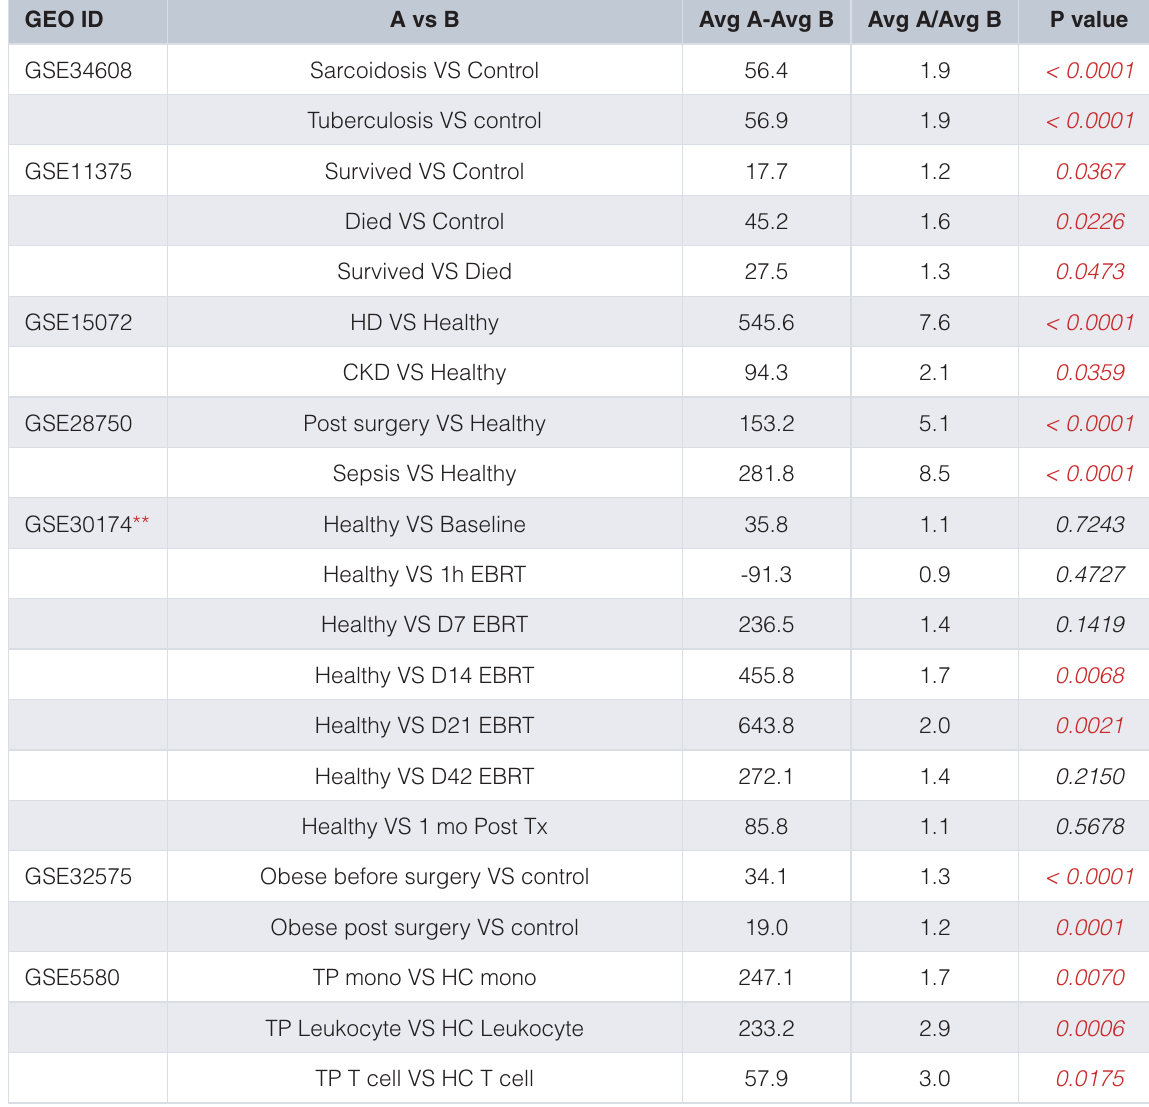
Table 4. Increased abundance of ADAM9 following tissue injury and sterile